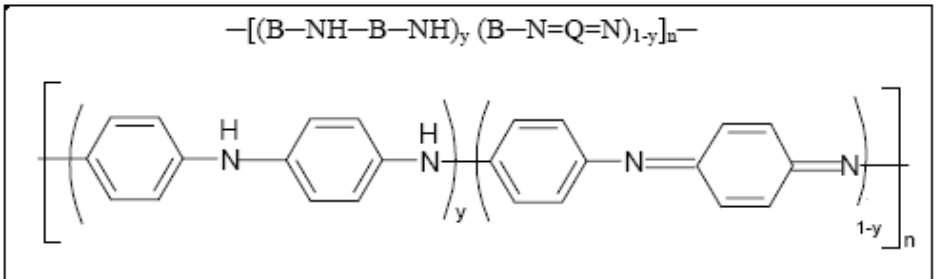
Fig.1: Structure of the polyaniline